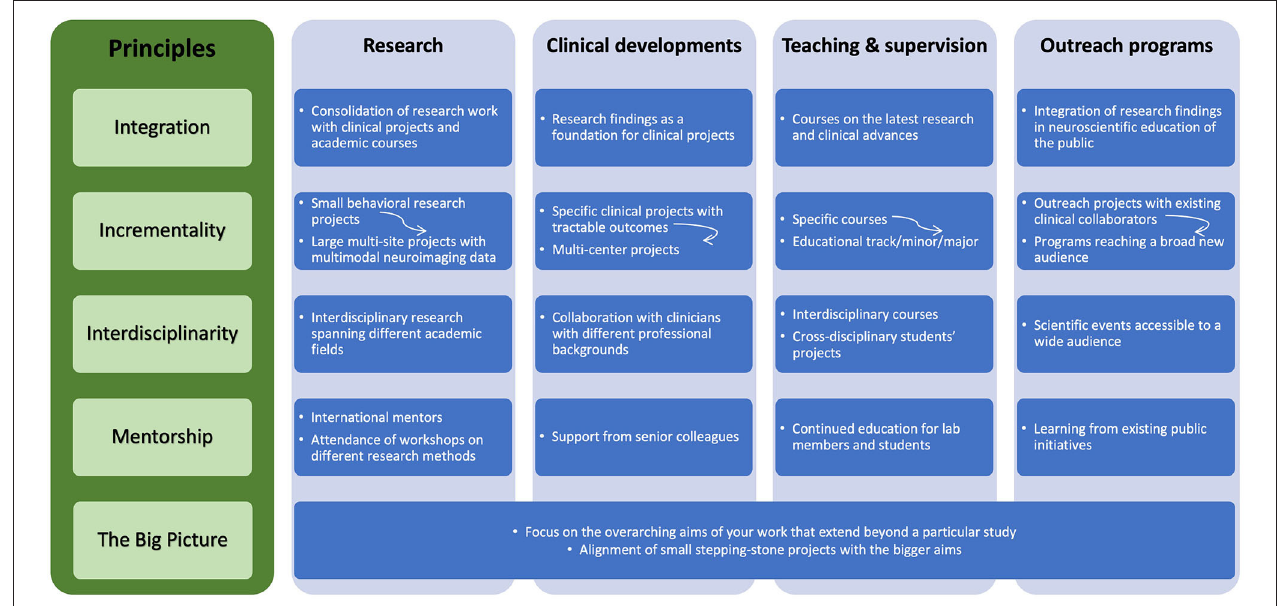
FIGURE 2 | Summary of the main working principles of scientific and educational program development as they apply to different areas of activity and service (research, clinical work, teaching and supervision, and public